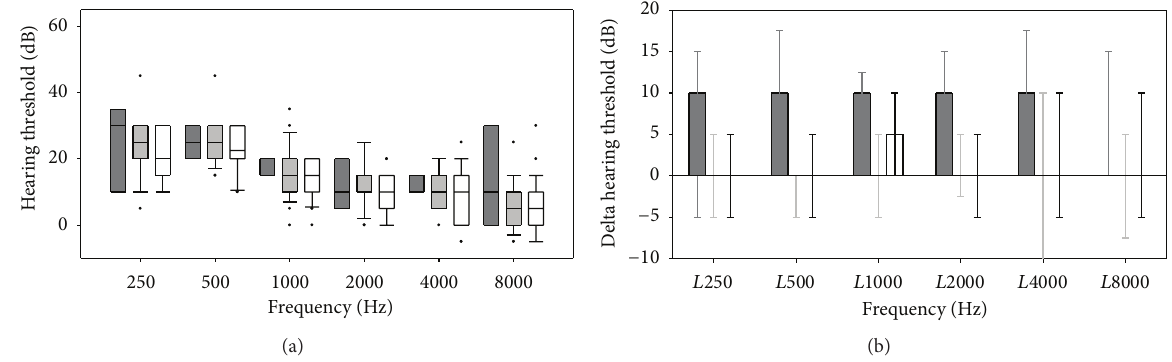
Figure 3: (a) Audiometry data at 9–12 months followup by treatment group. Amodiaquine (dark shaded, 𝑛 = 3 ), artemisinin-lumefantrine (light shaded, 𝑛 = 23 ), artesunate-amodiaquine (open, 𝑛 = 30 ). No difference could be shown across all wavelengths and both ears (two-way repeated measurement ANOVA on ranks 𝑃 = 0.7 ). (b) Hearing threshold on day 7 after treatment relative to threshold before treatment by group. Colours as (a). Columns and error bars as in Figure 2. Patients treated with amodiaquine alone had significant increase in hearing threshold across all wavelengths compared with patients treated with ACT, who had unchanged threshold compared to day 0 (two-way repeated measurement ANOVA on ranks 𝑃 < 0.001 , Holm-Sidak post hoc test of amodiaquine versus artemether-lumefantrine 𝑃 < 0.001 , of amodiaquine versus artesunate-amodiaquine 𝑃 = 0.003 , amodiaquine 𝑛 = 5 , artemether-lumefantrine 𝑛 = 21 , artesunate-amodiaquine 𝑛 = 15